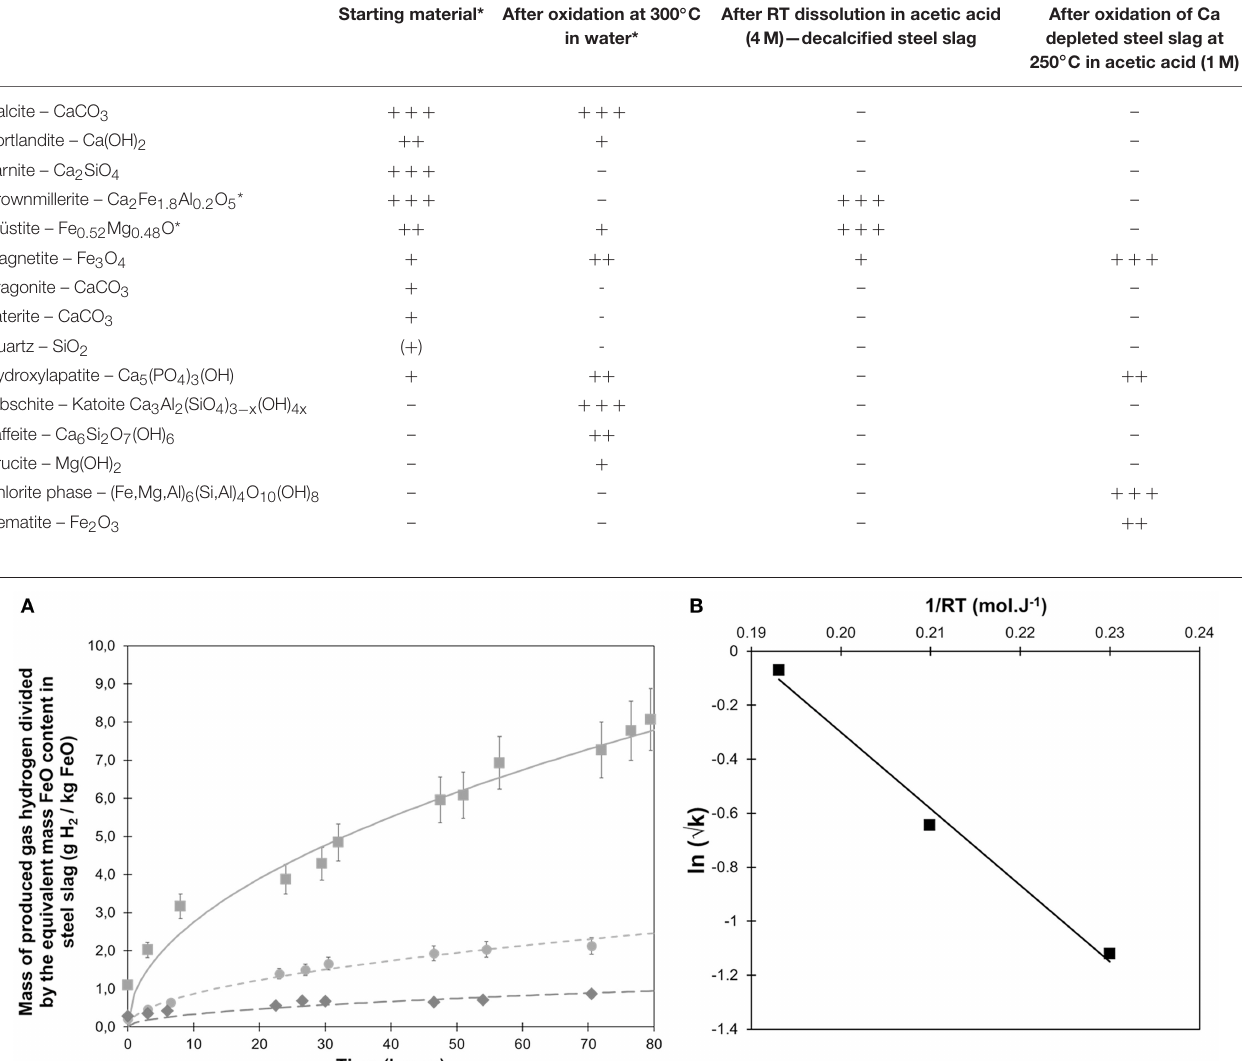
TABLE 2 | Mineralogical phases and relative abundance deduced from semi-quantitative Rietveld refinement Chemical formula is given as a qualitative information except for phases marked with a star (*) for which data were retrieved from initial steel slag characterization (Crouzet et al., in press); +++ dominant, ++ abundant, + minor, ( + ) trace.